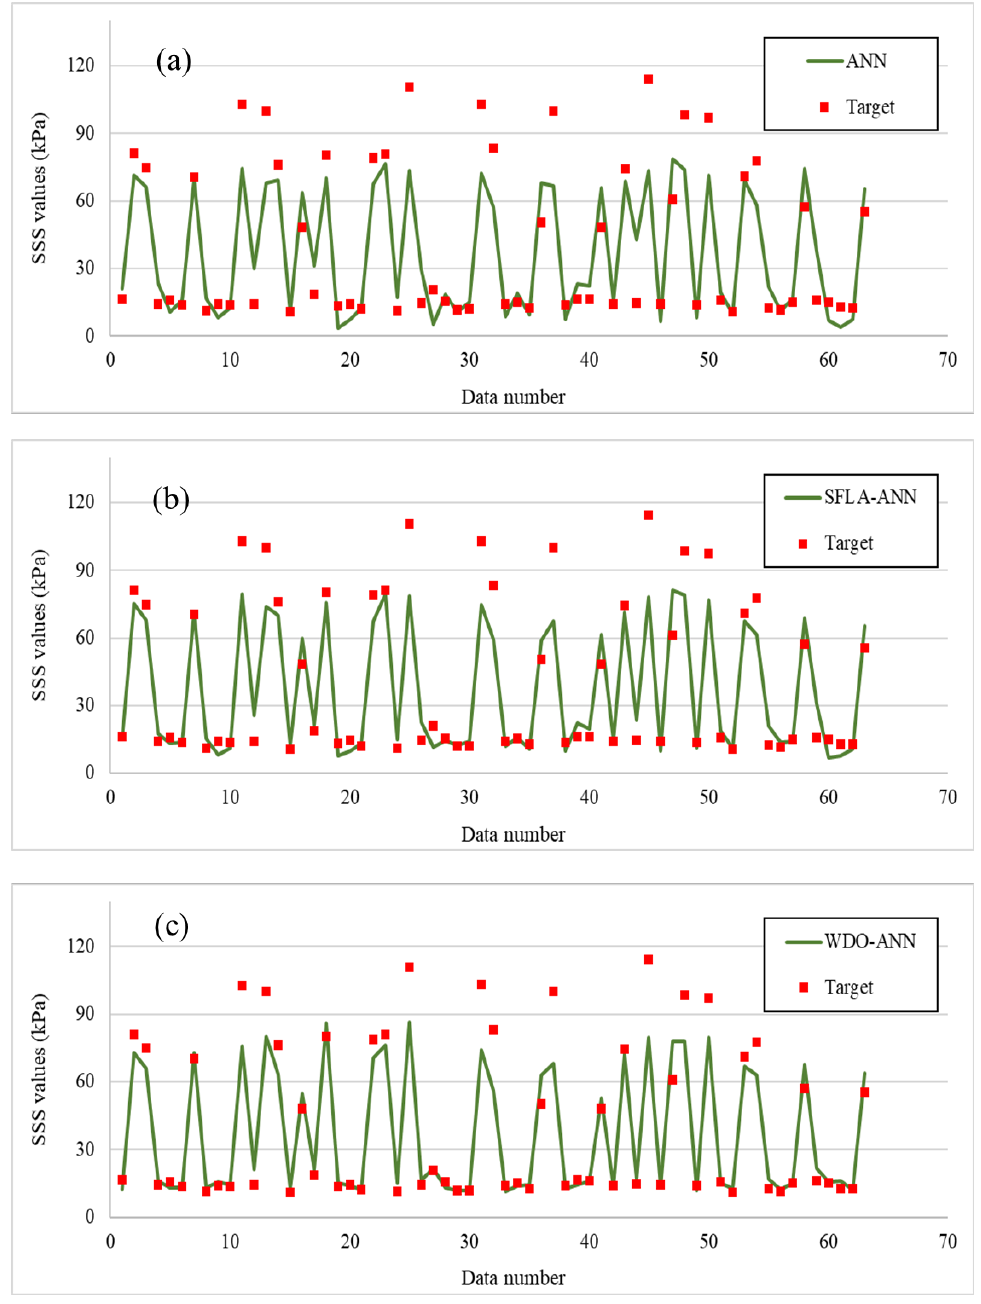
Figure 7. The testing results of the implemented ( a ) typical ANN, ( b ) SFLA – ANN, and ( c ) WDO – ANN.